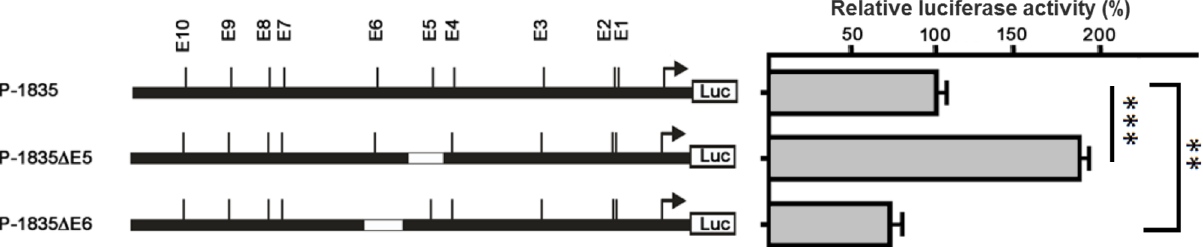
Fig 2. E-box E5 and E6 regulation of grouper myostatin promoter activity. The construct containing internaltruncationsof E-box E5 (P- 1835 Δ E5)or E6 (P-1835 Δ E6) was transfected into GF-1 cells, respectively,and luciferase reporter activity was measured. The relative luciferaseactivity was normalized against that of the pGL3-Basic vector. Bars indicateaverages ± standard deviations for three replicates and asterisks show significantdifferences ( ** p < 0.01, *** p < 0.001).